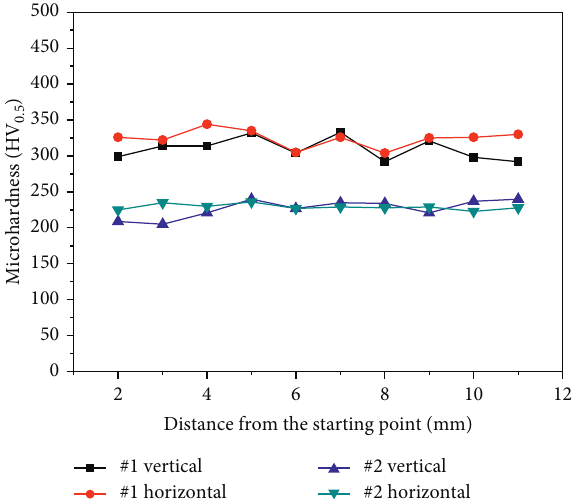
Figure 10: Microhardness distribution of the 2.25Cr1Mo0.25V sample made by